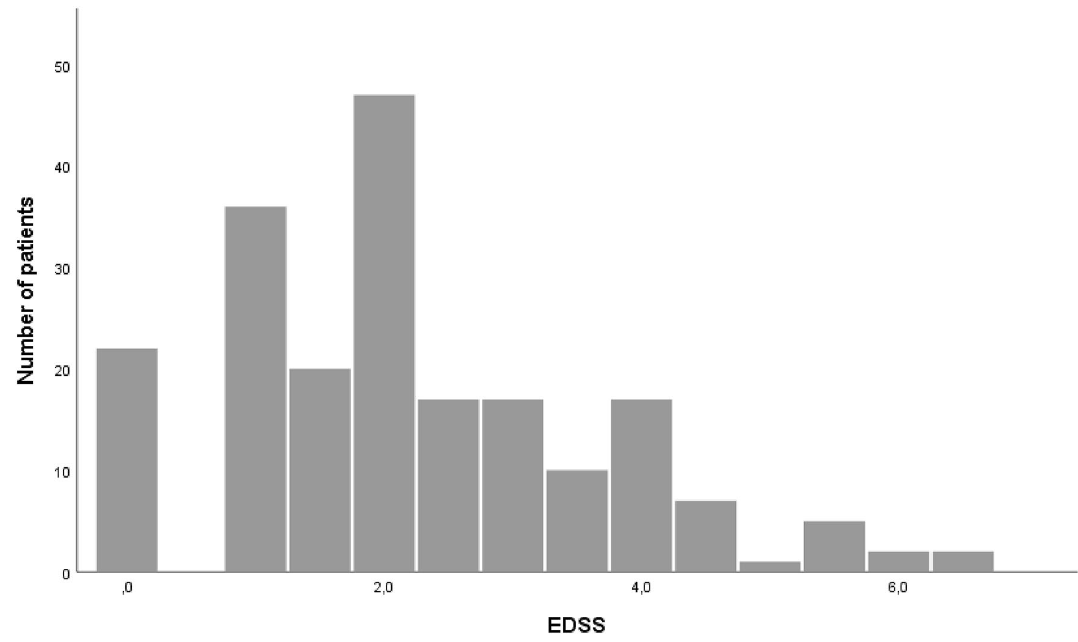
Figure 2. EDSS score at treatment start with